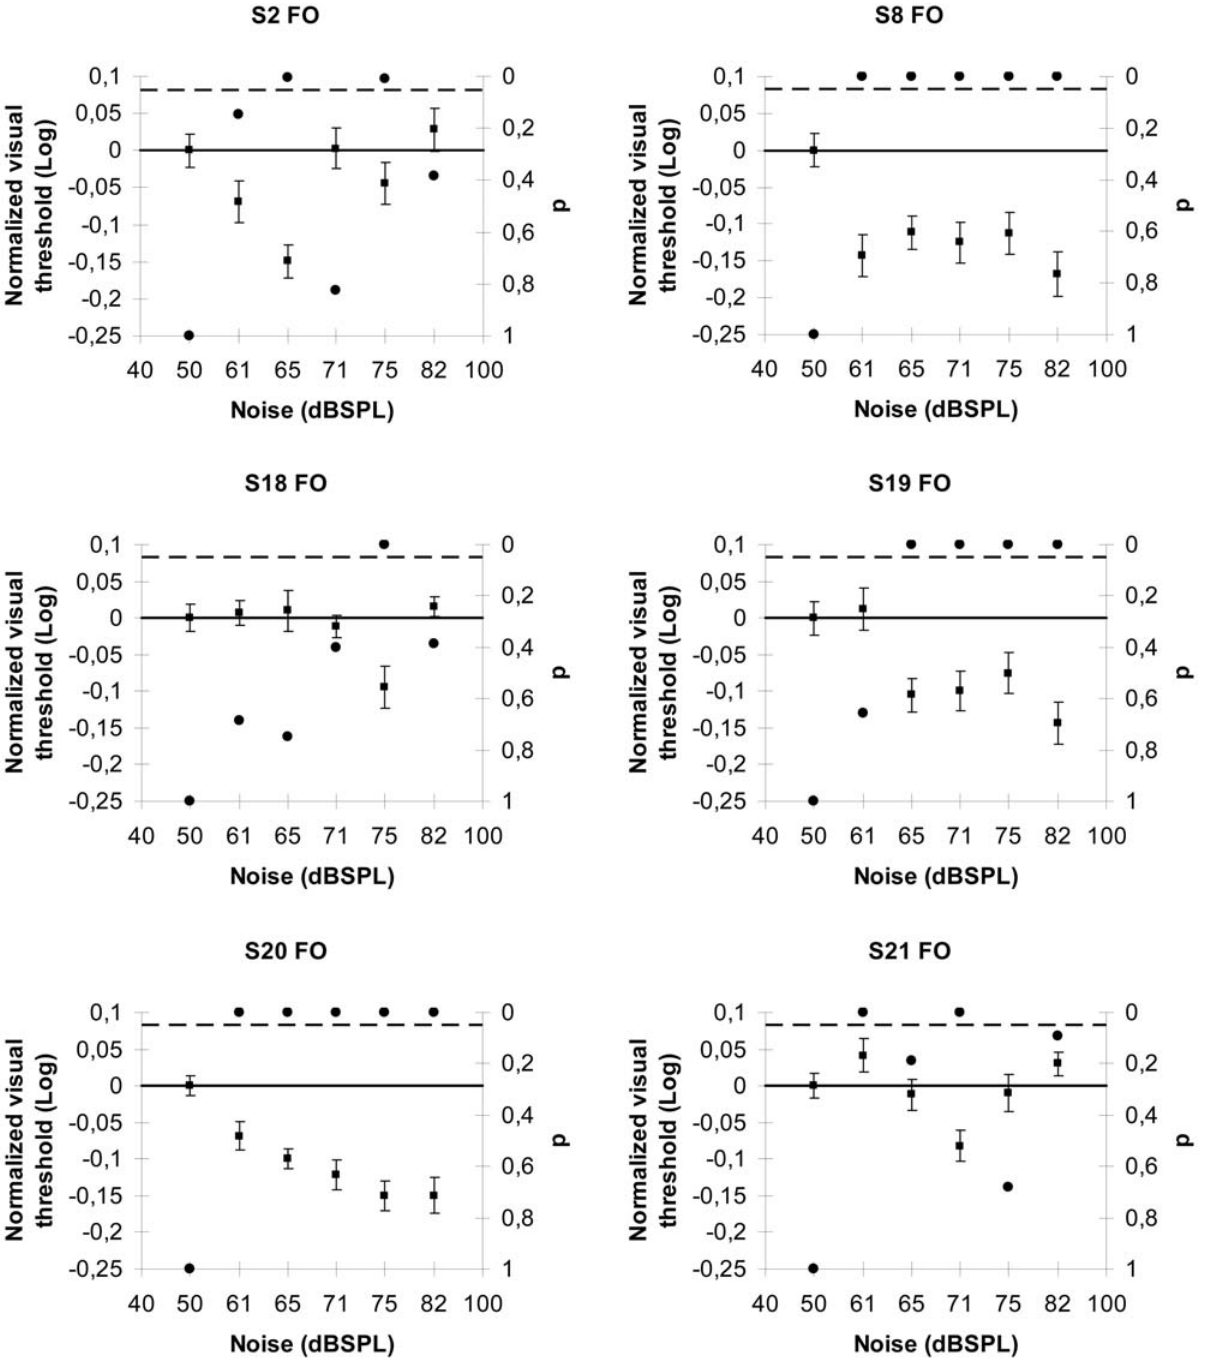
Figure 2. SR interactions between auditory noise and first order visual signals. Normalized visual threshold changes with the noise level in sixth subjects for luminance modulated (first order) stimuli. In all the graphs the no-noise condition is taken as baseline; the black dots indicate p- values (right y-axis) and the broken line represents the 5% significance level. Error bars correspond to one standard error. doi:10.1371/journal.pone.0002860.g002 parameters. Additional model parameters are those defining the polynomial V ( x ), and the constants defining the stepwise variation of e . We note that the dimensional counterparts of the terms x¨ , e s G ( t ) are respectively d 2 Y / d t 2 , e c Cos (2 p f v p f 0 t ), and ( 0 =2 0 ),